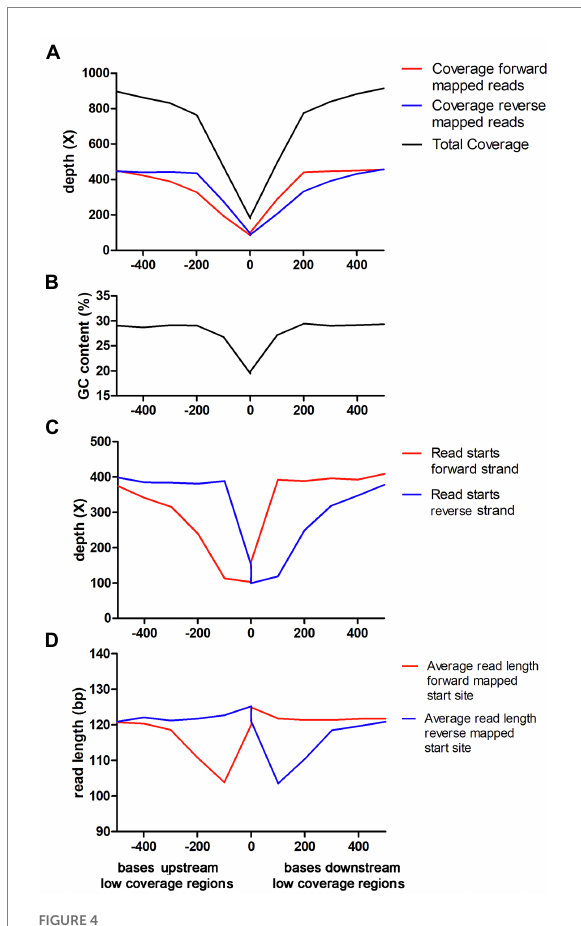
FIGURE 4 Characterization of low coverage regions for Nextera XT laboratories in the Campylobacter jejuni PT 28 dataset. Note that the X-axis is the same in all panels and the description is found in the lowest panel. (A) Average read depth of forward and reversed mapped reads upstream and downstream the low coverage regions. (B) GC-content upstream and downstream the low coverage regions. (C) Average number of read starts of forward and reversed mapped reads upstream and downstream the low coverage regions. (D) Average read length of forward and reversed mapped reads upstream and downstream the low coverage